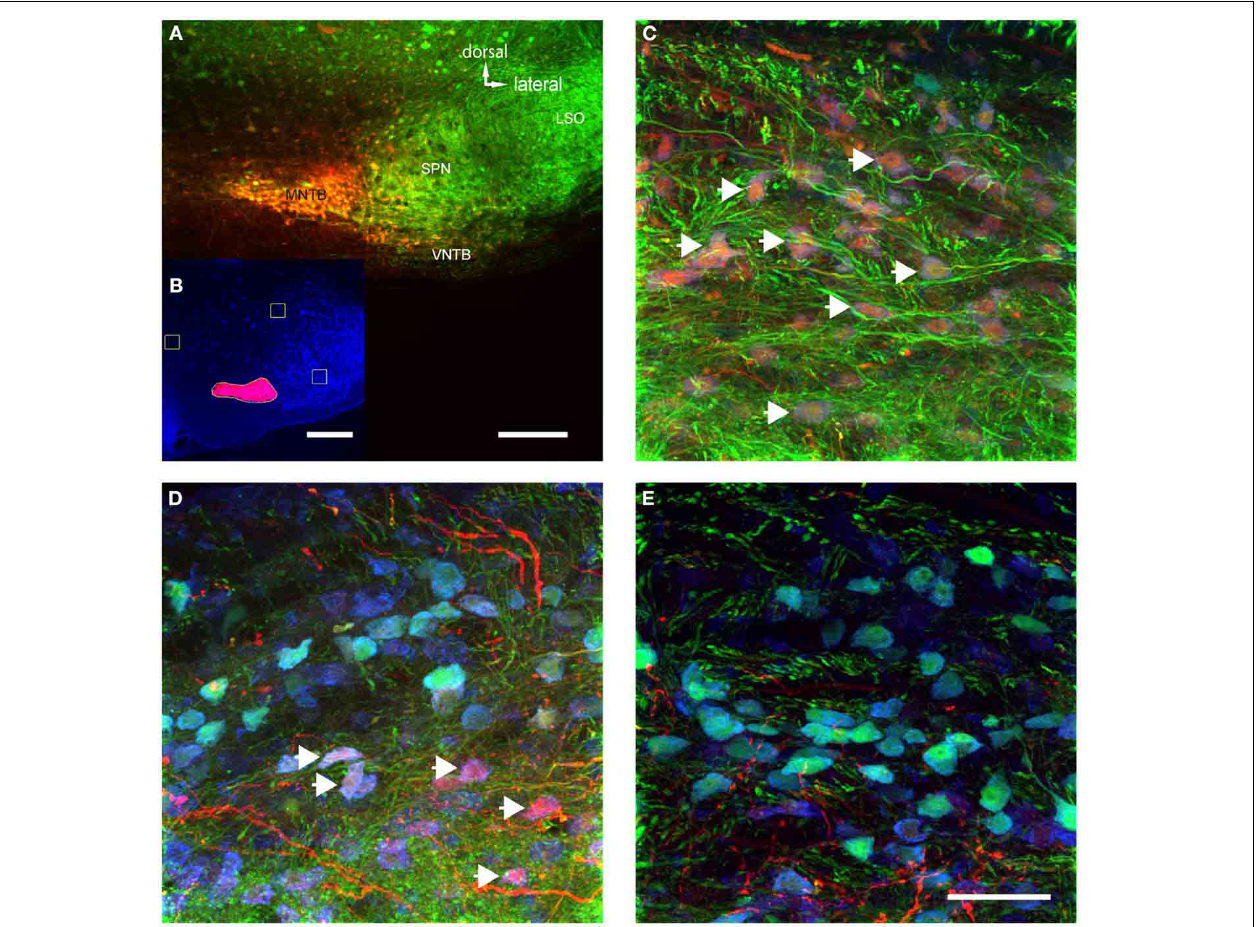
FIGURE 5 | The volume of TMR-injections into MNTB correlates with the number of labeled VNTB neurons. (A) A brain stem image showing a TMR-injected (red) MNTB. (B) The result of a semi-automatic analysis of the same injection with our custom-built MATLAB algorithm, illustrating the method of quantifying the apparent extent of the tracer injection. (C) Shows a section of VNTB from a brain where the tracer injection into the ipsilateral MNTB was extensive (65% of MNTB volume). (D) represents a section of